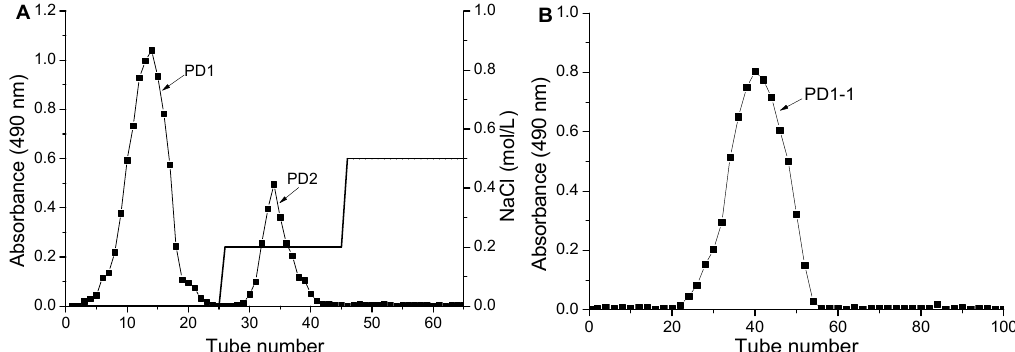
Figure 1. Chromatograms from ( A ) Diethylaminoethyl (DEAE) cellulose fast flow anion-exchange column chromatography of crude polysaccharides, and ( B ) Sephadex G-75 column chromatography of PD1.